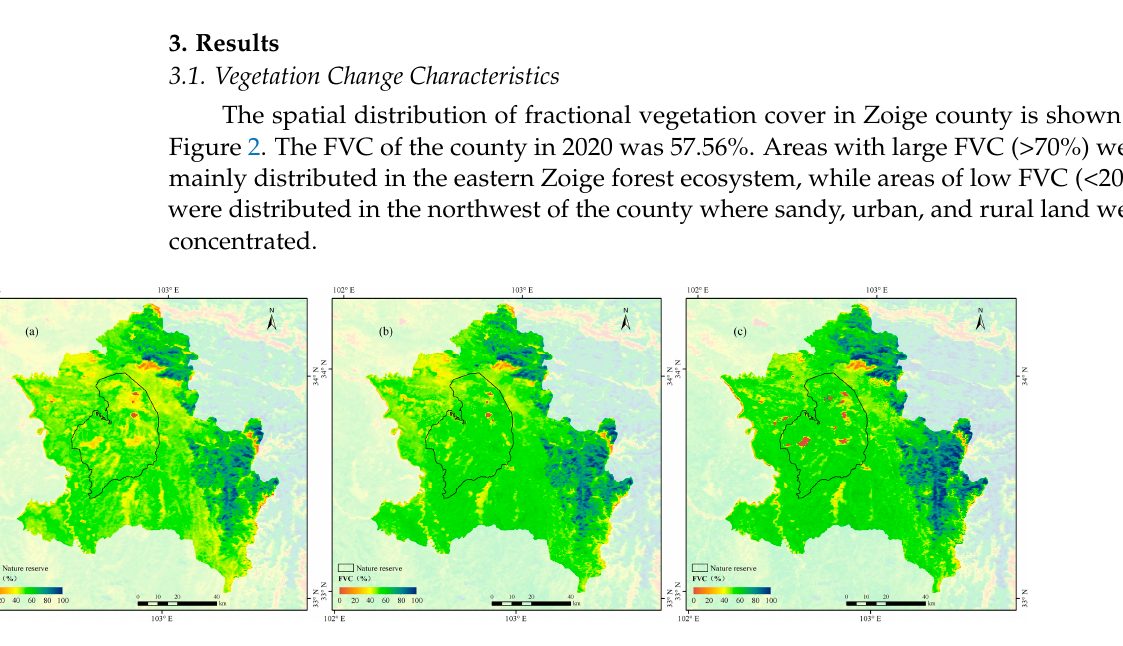
Figure 2. Spatial distribution of fractional vegetation cover (FVC) in Zoige in ( a ) 2001, ( b ) 2010,